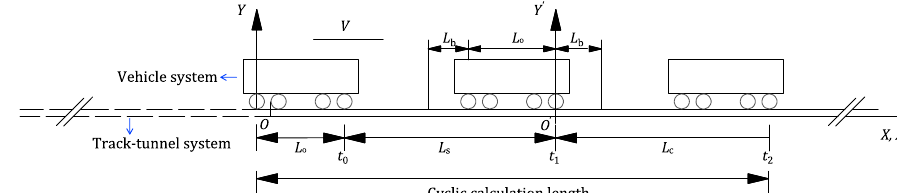
Fig. 5 Solution procedure for VTT